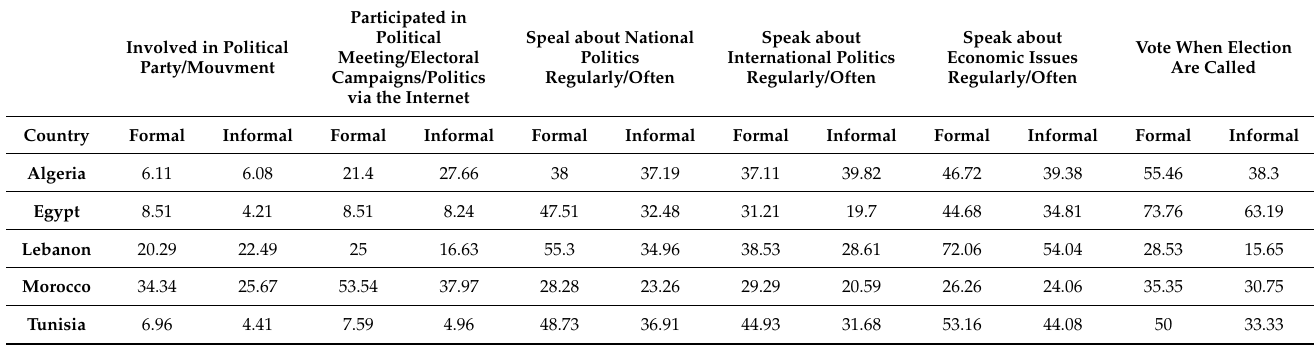
Table A2. Percentage of formal and informal workers participating to political activities by